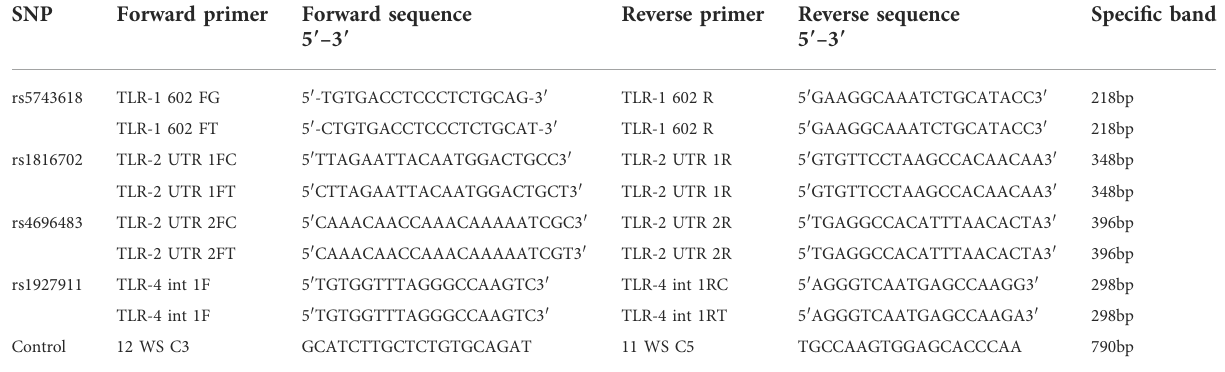
TABLE 1 Sequence of primers used for genotyping TLR1, TLR2, and TLR4 by